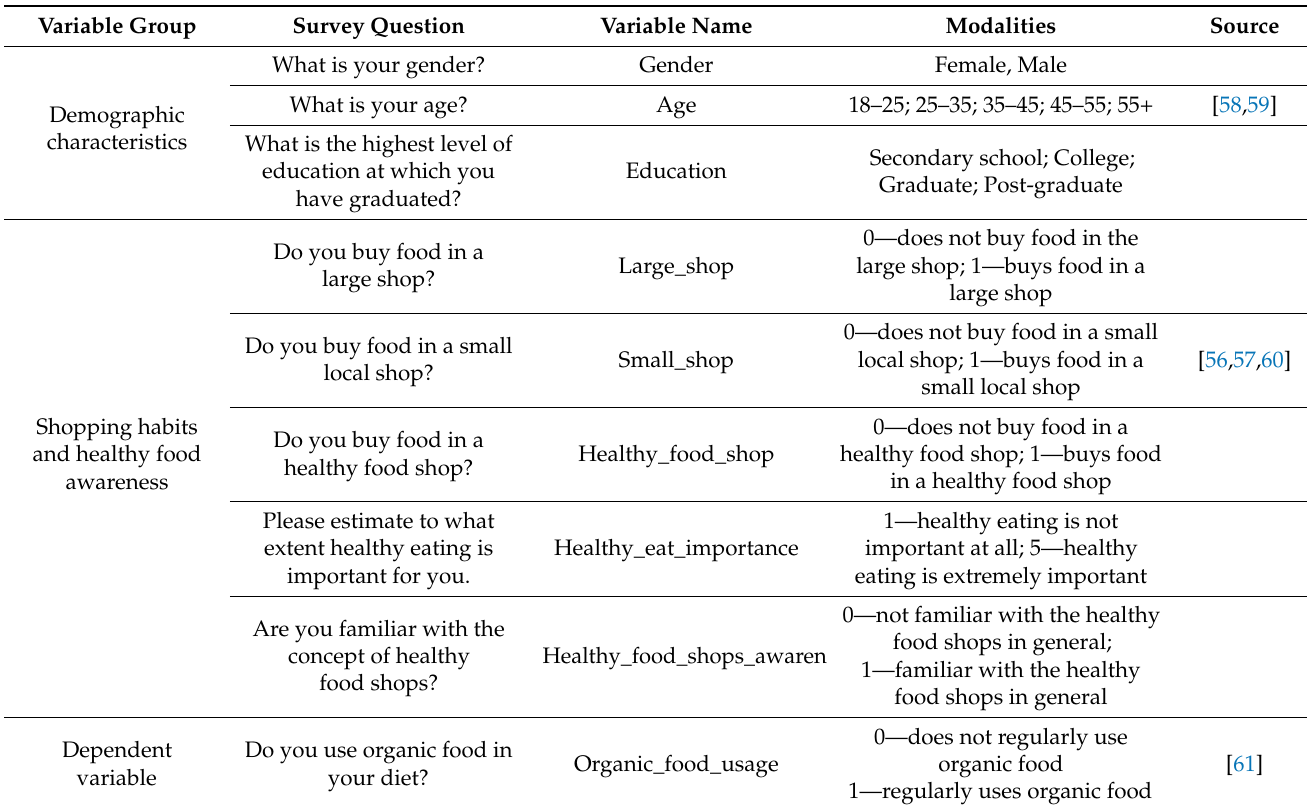
Table 1. Research